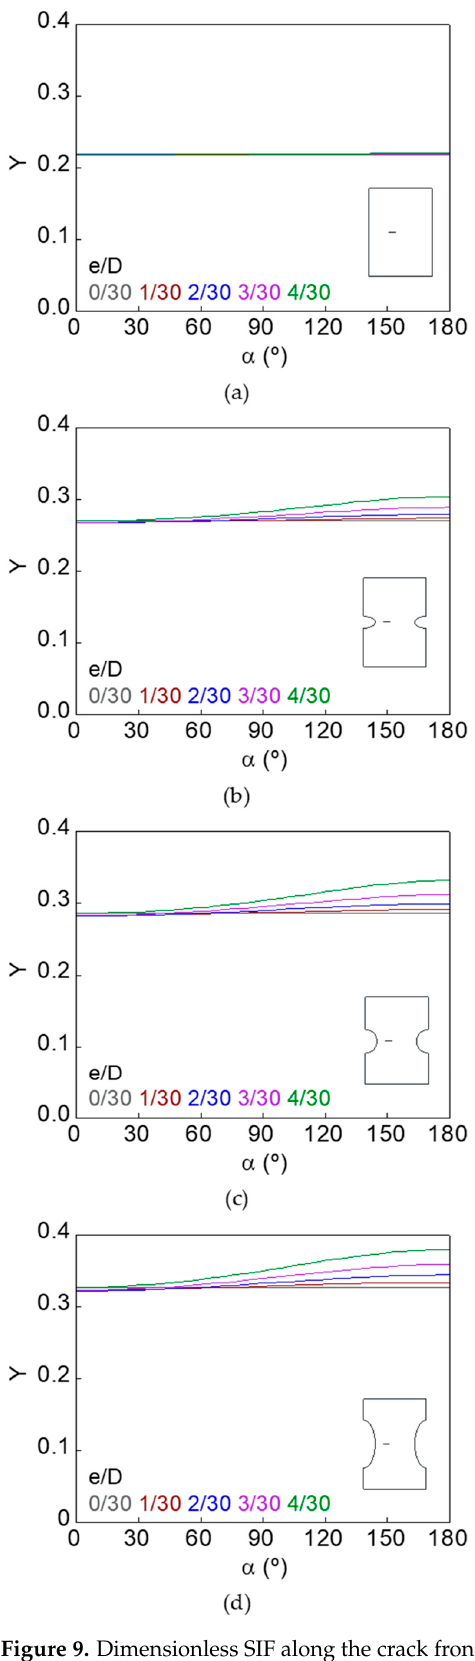
Figure 9. Dimensionless SIF along the crack front, d / D = 7/30: ( a ) smooth bar; ( b ) sharp notched bar; ( c ) circular notched bar; ( d ) blunt notched bar.